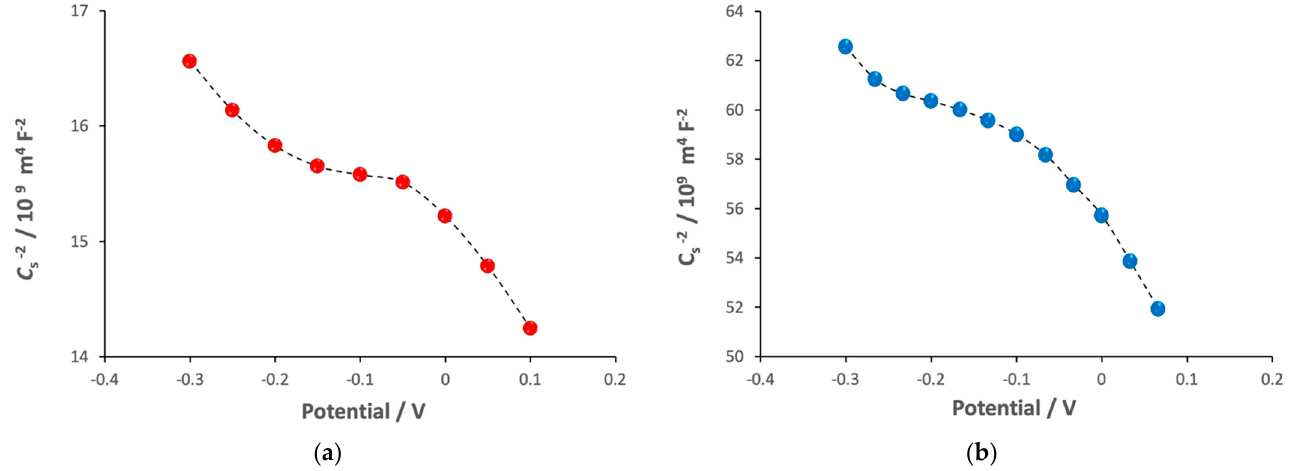
Figure 5. Mott–Schottky plot of the electrodeposited Cu 2 O films at − 0.35 V vs. Ag/AgCl for 15 min at ( a ) pH 10 and ( b ) pH 7. Analysis made at 1 kHz for both samples.